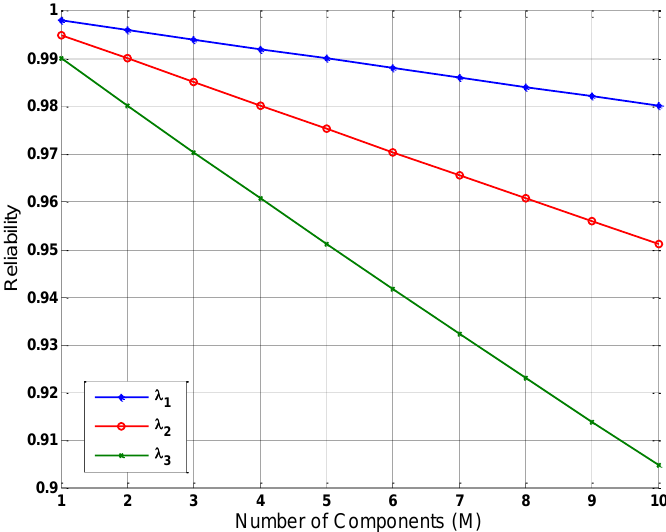
Figure 5. System reliability with different failure rates and number of components.